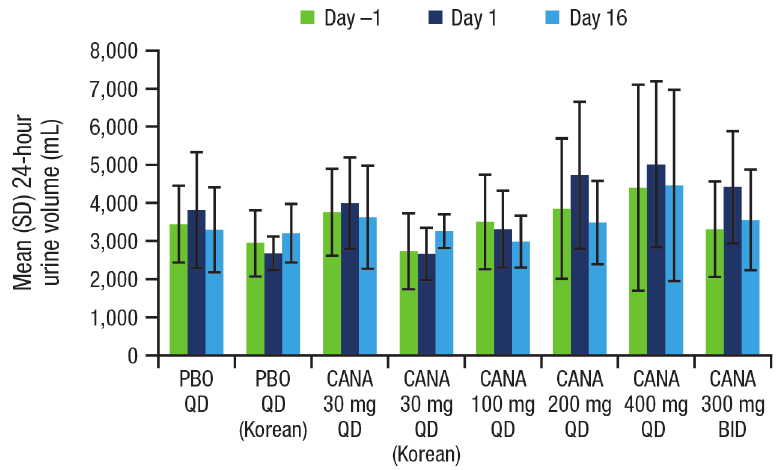
Figure 7. Mean 24-hour urine volume at baseline (Day –1) and after a single dose (Day 1) and after multiple doses (Day 16). SD, standard deviation; PBO, placebo; CANA, canagliflozin; QD, once daily; BID, twice daily.